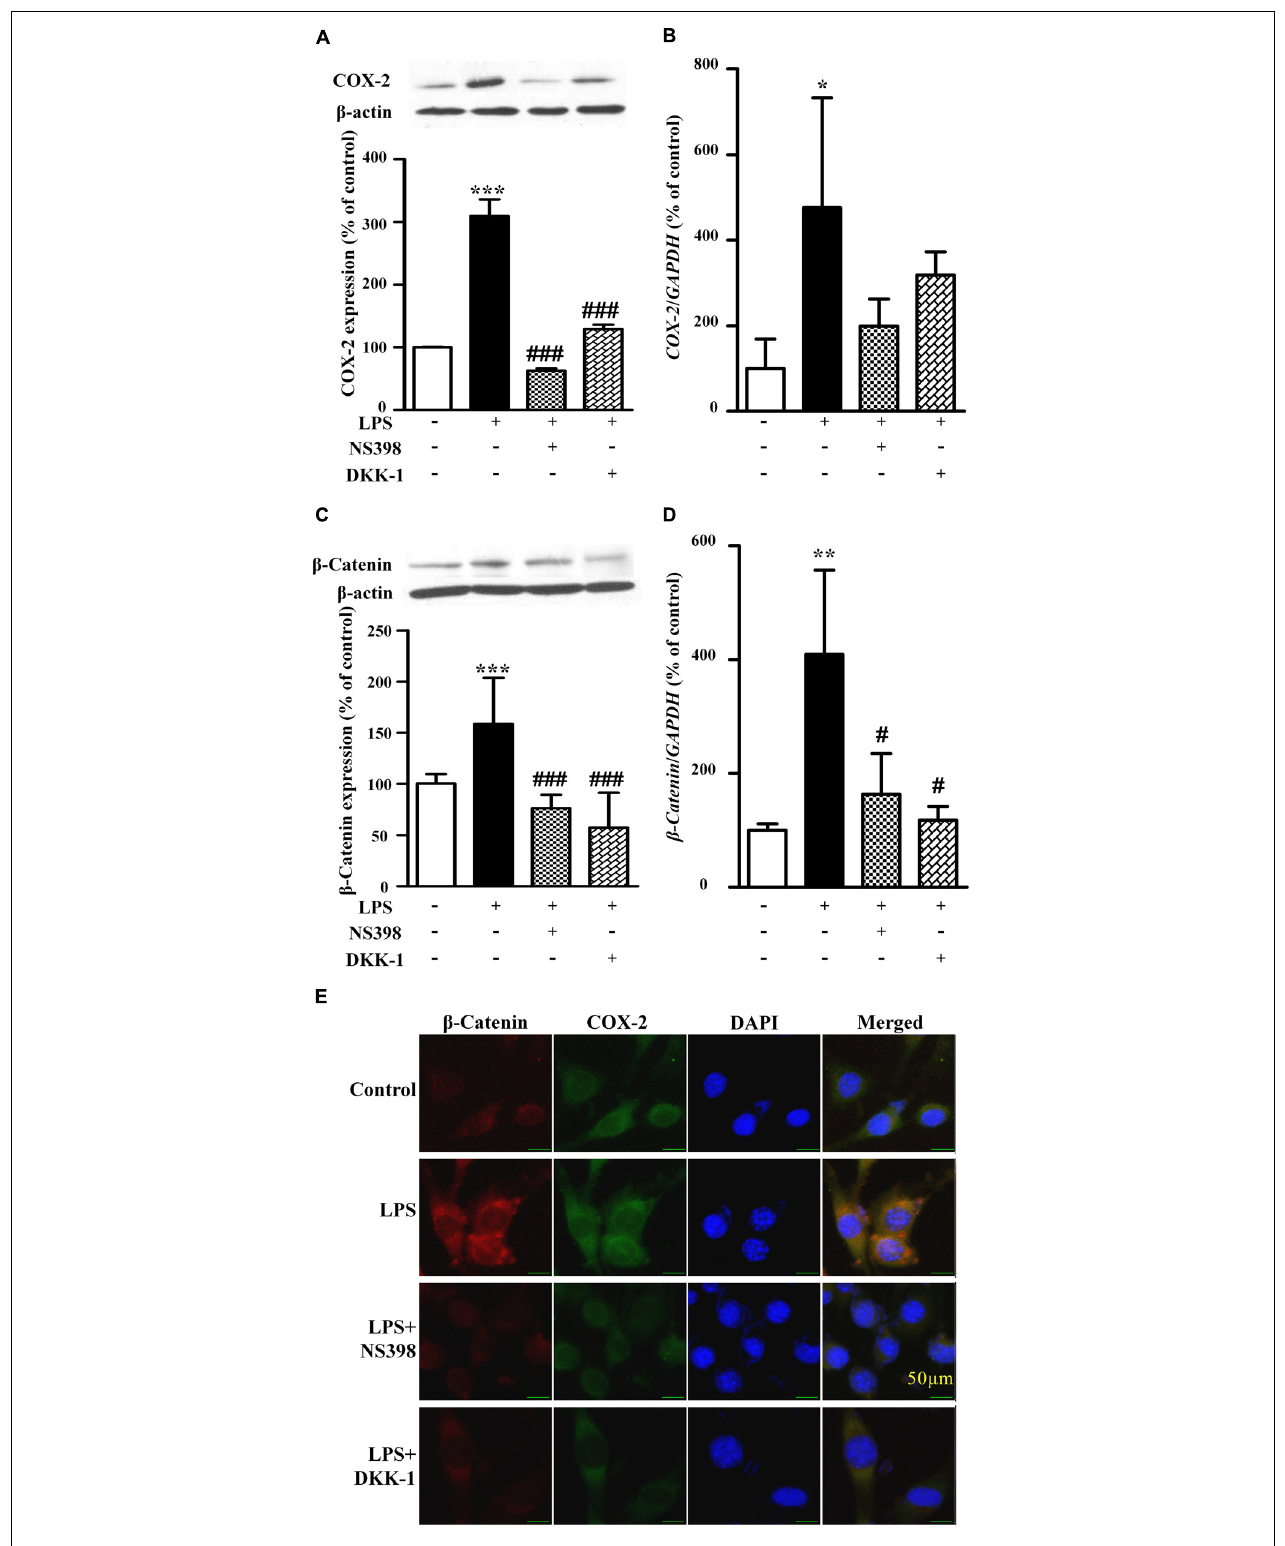
FIGURE 4 | The protein expression and mRNA levels of β -catenin and COX-2 in the NIH3T3 cells treated with LPS. The protein and mRNA expression quantitative analysis of COX-2 (A,B) or β -catenin (C,D) in NIH3T3 cells. The quantitative analysis of protein was measured by ImageJ. ∗ P < 0.05, ∗∗ P < 0.01, and ∗∗∗ P < 0.001 vs. control; # P < 0.05 and ### P < 0.001 vs. the LPS group, n = 3. (E) The immunofluorescence staining of β -catenin and COX-2 in the NIH3T3. Scale bars: 50 µ